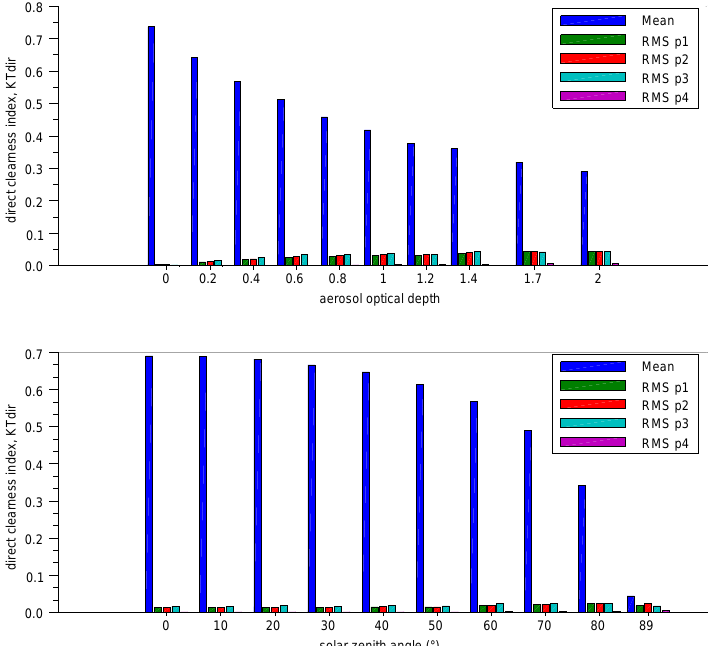
Figure 4. Variation of KTdir and of corresponding RMS with aerosol optical depth and solar zenith angle. Spectral and total KT are mixed